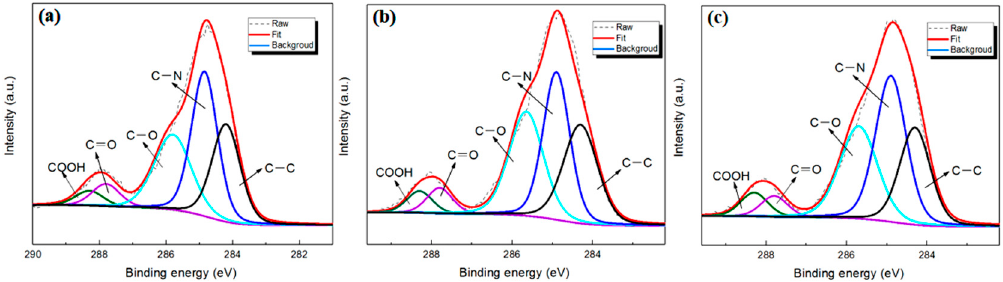
Figure 7. XPS peak analysis of the RO membrane surface: ( a ) Virgin; ( b ) TFN － 2; ( c ) TFN － 5.